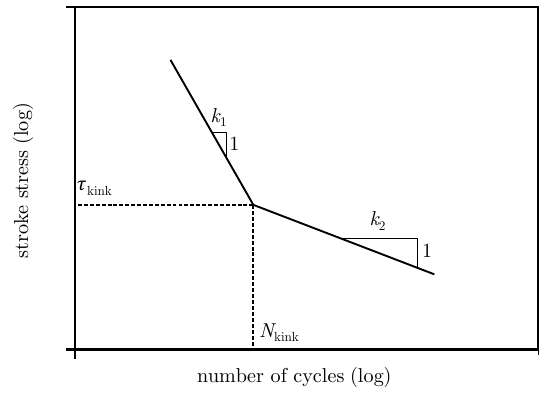
Figure 3. Parameters used in the numerical implementation of the